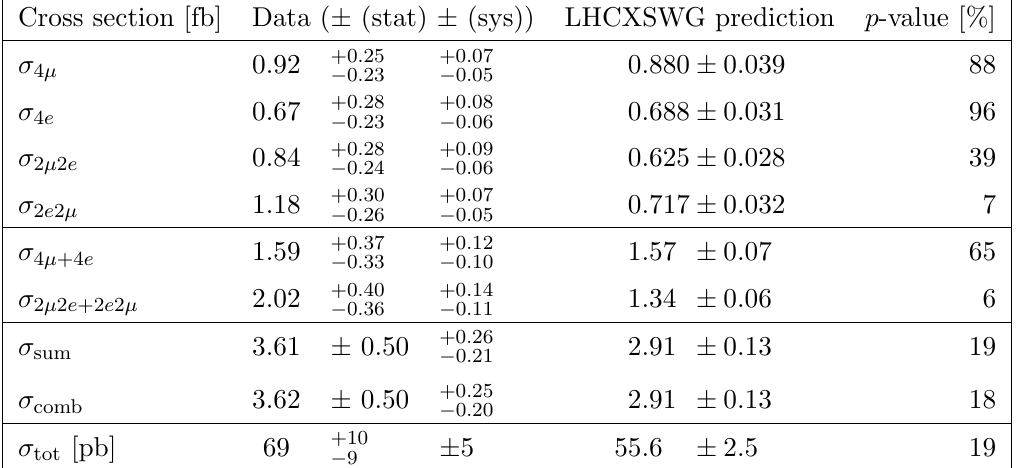
Table 4. The (cid:12)ducial and total cross sections of Higgs boson production measured in the 4 ‘ (cid:12)nal state. The (cid:12)ducial cross sections are given separately for each decay channel, and for same- and opposite-(cid:13)avour decays. The inclusive (cid:12)ducial cross section is measured as the sum of all channels, as well as by combining the per-channel measurements assuming SM ZZ (cid:3) ! 4 ‘ branching ratios. The LHCXSWG prediction is accurate to N3LO in QCD for the ggF process. For the (cid:12)ducial cross- section predictions, the LHCXSWG cross sections are multiplied by the acceptances